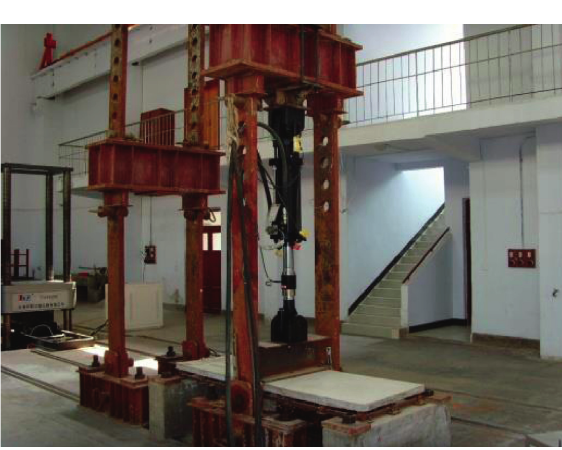
Figure 4: Test setup